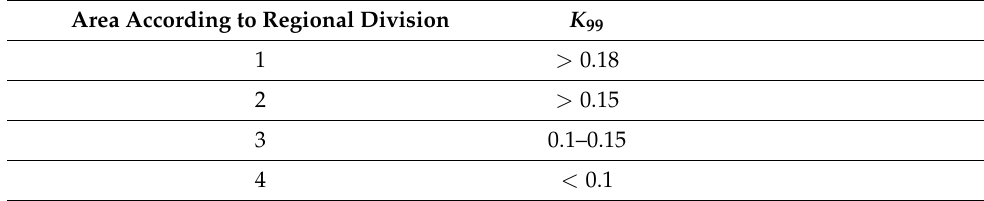
Table 2. K 99 values in four defined